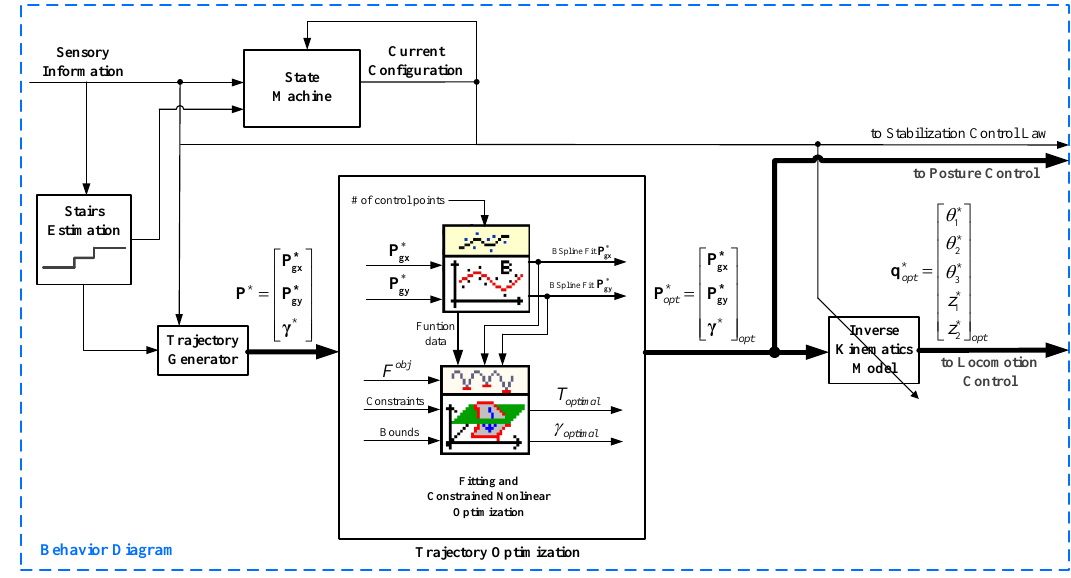
Figure 15. Scheme of the optimal trajectory generator based on constrained nonlinear